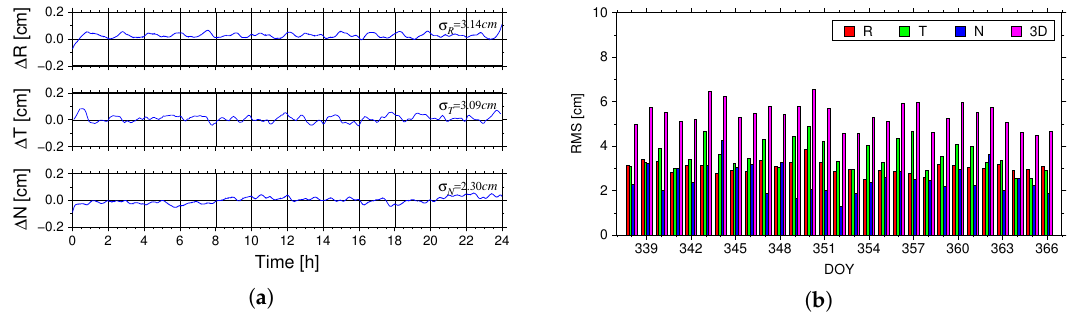
Figure 8. ( a ) is the differences between the dynamic and reduced-dynamic orbit on 3 December 2016. ( b ) is the RMS statistics of the differences between the dynamic and reduced-dynamic orbit for DOY 338–366,